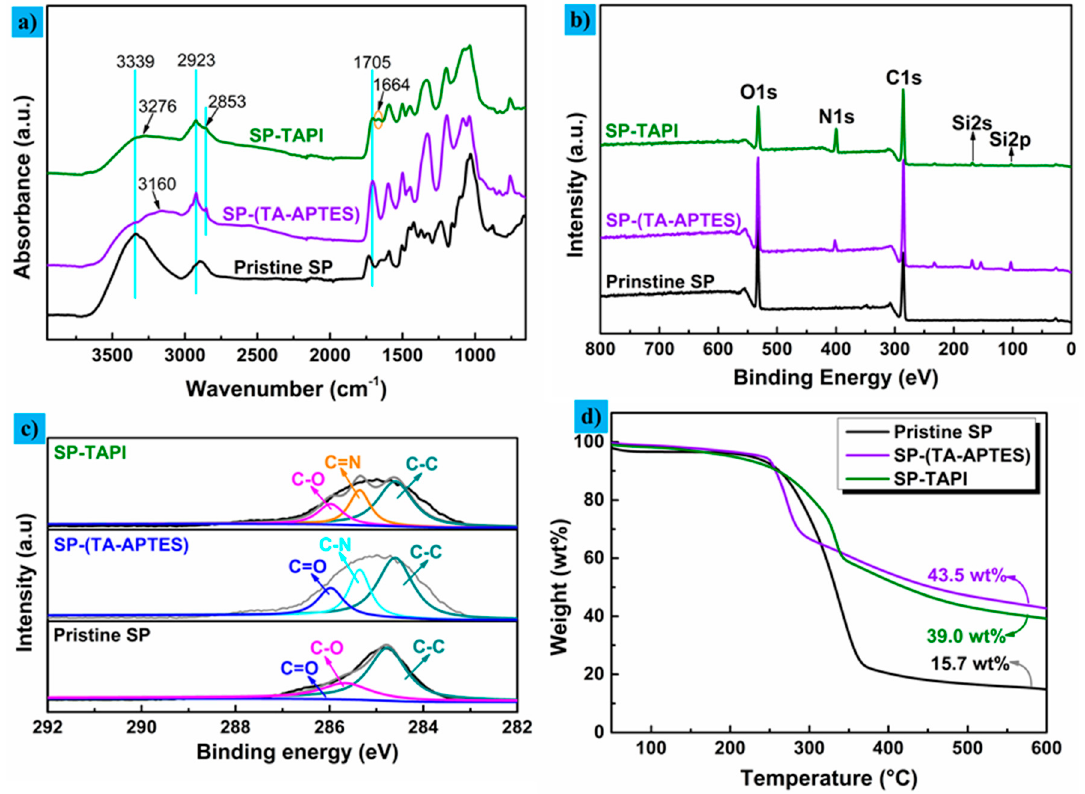
Figure 1. ( a ) Fourier-transform infrared spectroscopy (FTIR) spectra of pristine SP, SP-(TA-APTES), and SP-TAPI. ( b ) Wide-scan XPS spectra and ( c ) deconvolution curves of C 1s spectra of pristine SP, SP-(TA-APTES), and SP-TAPI. ( d ) Thermogravimetric analysis (TGA) curves of pristine SP, SP-(TA-APTES), and SP-TAPI.